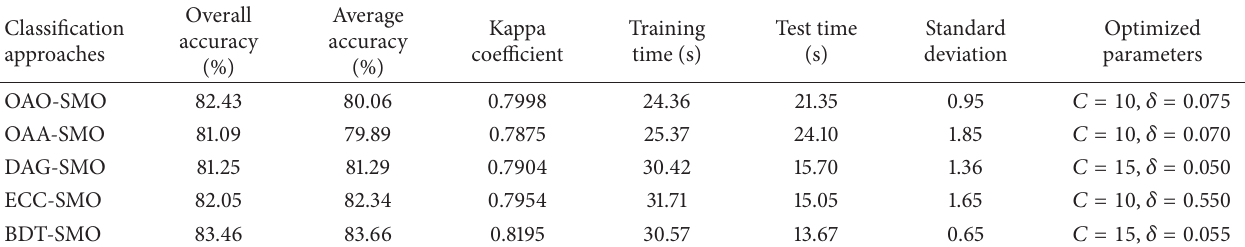
Table 4: Comparison of classification results under different SMO multiclass classification approaches (zone 1).